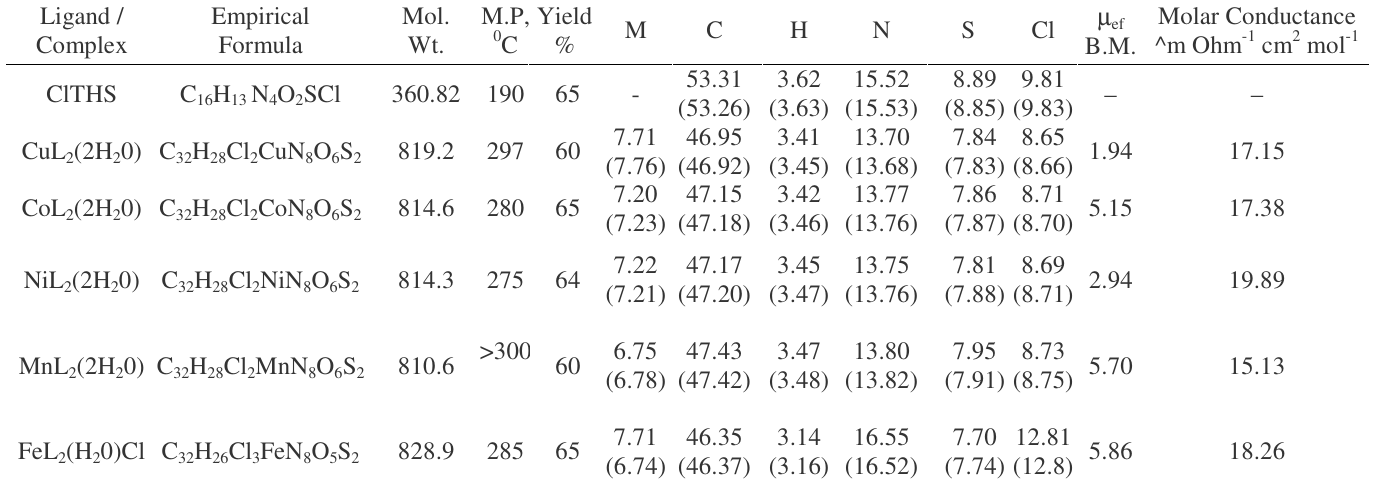
Table 1. Physical, analytical, magnetic susceptibility and molar conductance data of the ligand ClTHS and its complexes Ligand